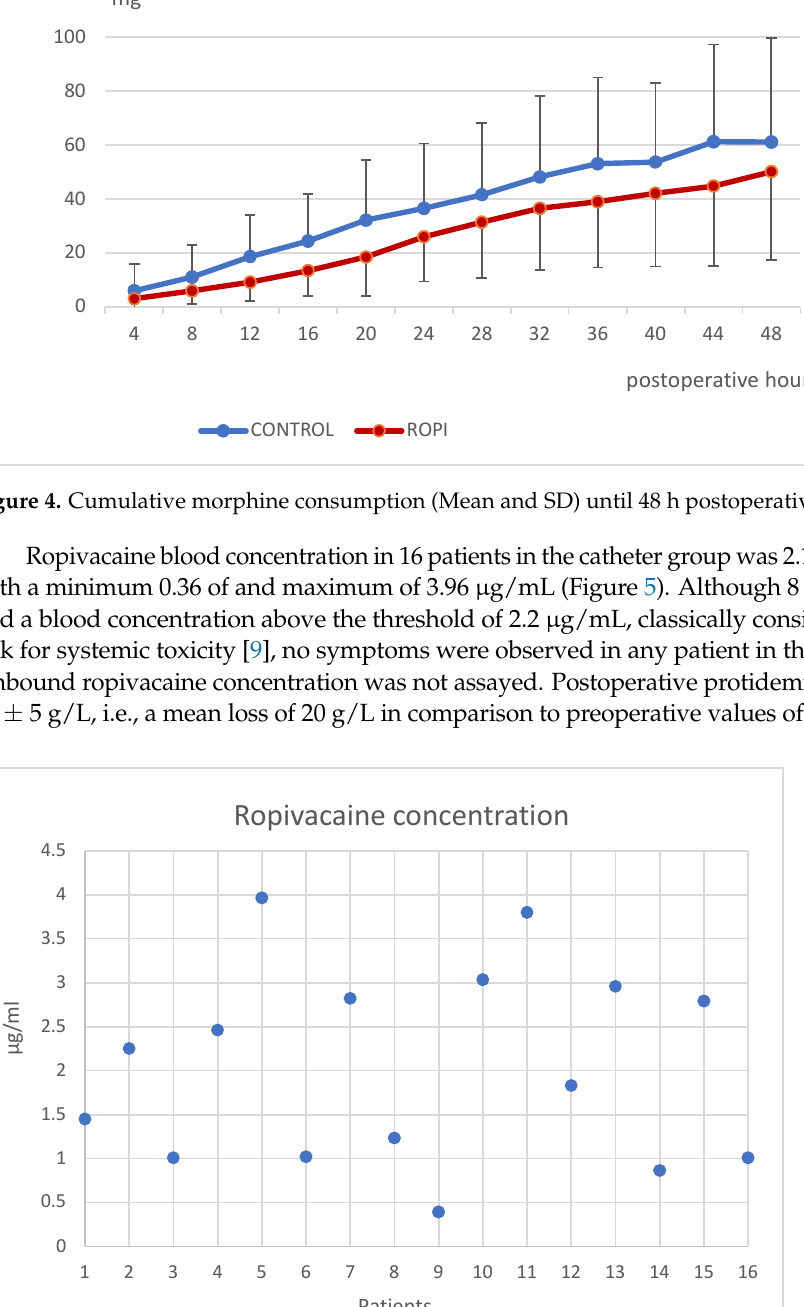
Figure 5. Individual values of ropivacaine blood concentration at the end of infusion. All patients had at least 1-year follow-up and one third of them had retrospective electronic assessment up to 10 years. In this long-term retrospective analysis, only one patient, in the ROPI group had moderate chronic pain sequelae in the fibula harvest site, which lasted up for 6 years. No other pain in the harvest site was reported.